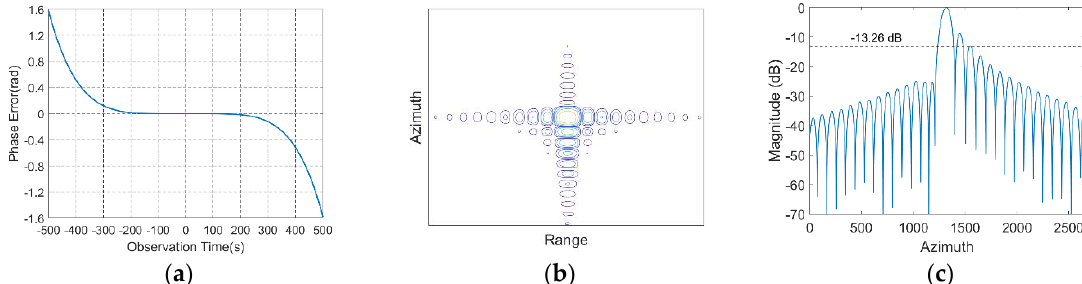
Figure 16. The fitting error and focusing result of the fourth-order expansion at 45° of true anomaly. ( a ) Fitting error; ( b ) 2-D contour; and ( c ) azimuth profile.